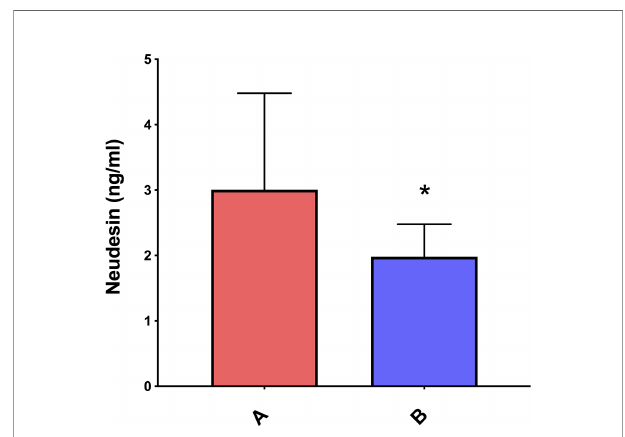
FIGURE 2 | Mean ± SD neudesin plasmatic concentrations in obese/ overweight versus normal-weight children. *p < 0.05. A= obese/pverweight children; B= normal-weight